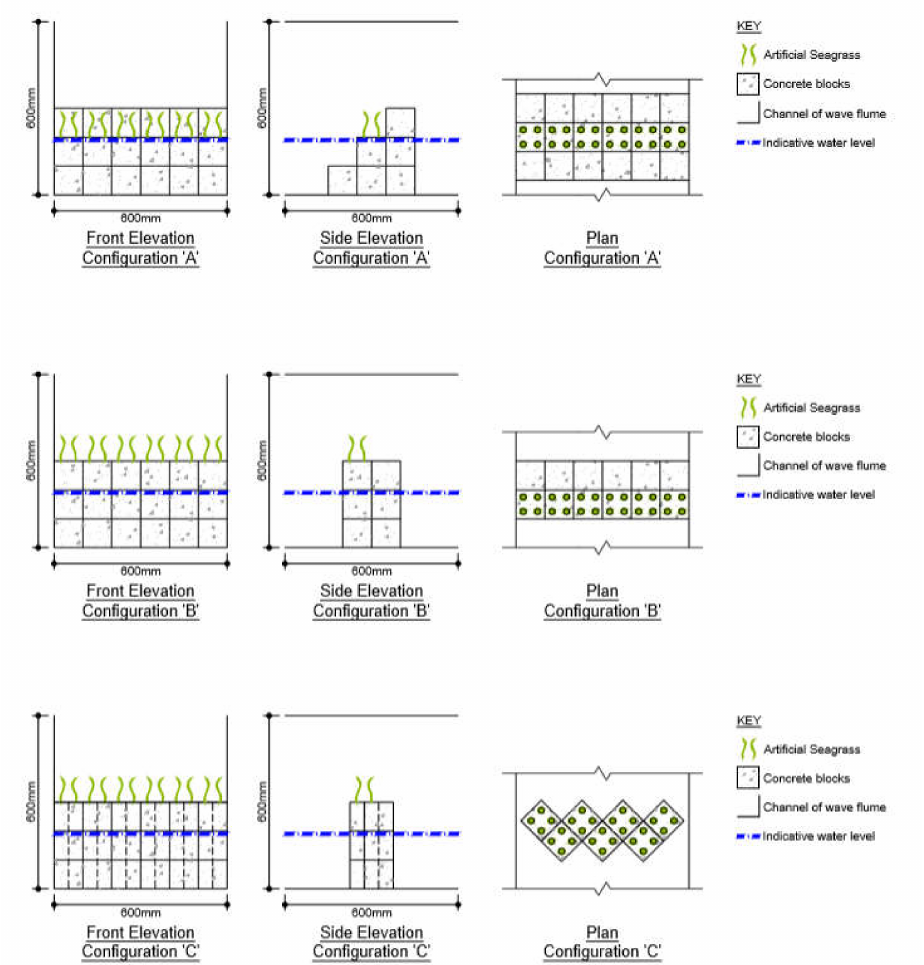
Figure 2. Sustainable coastal protections. Configurations A–C identified in this